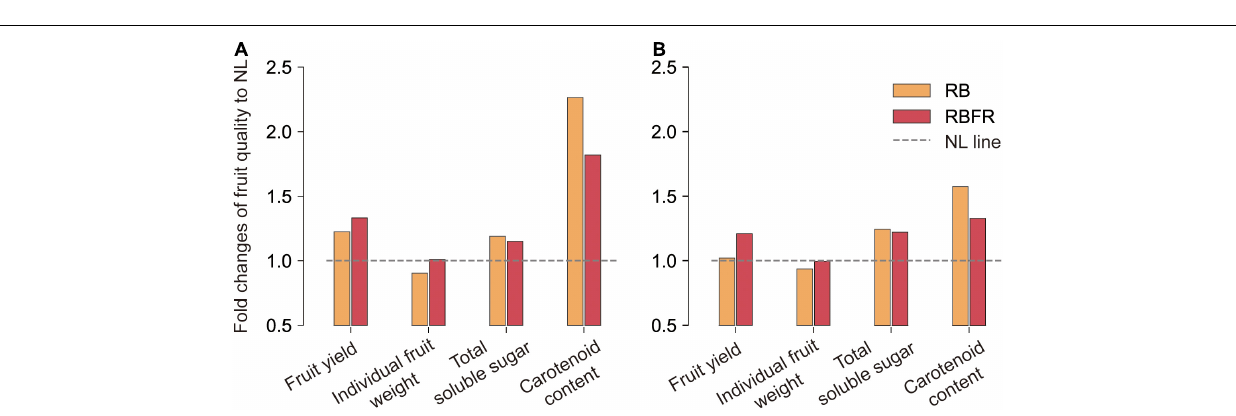
FIGURE 5 | Total and individual carotenoid contents ( µ g g − 1 FW) of red (A) and yellow (B) fruits of sweet peppers grown under natural light (NL), NL with red + blue LED interlighting (RB), and RB with far-red light (RBFR), respectively. Different letters indicate significance for light treatments within the same fruit color, as determined by Tukey’s HSD test, α = 0.05. Mean ± SD (n = 4) Groups 1 and 2 indicate fruits sampled at different harvesting periods as shown in Figure 1 .